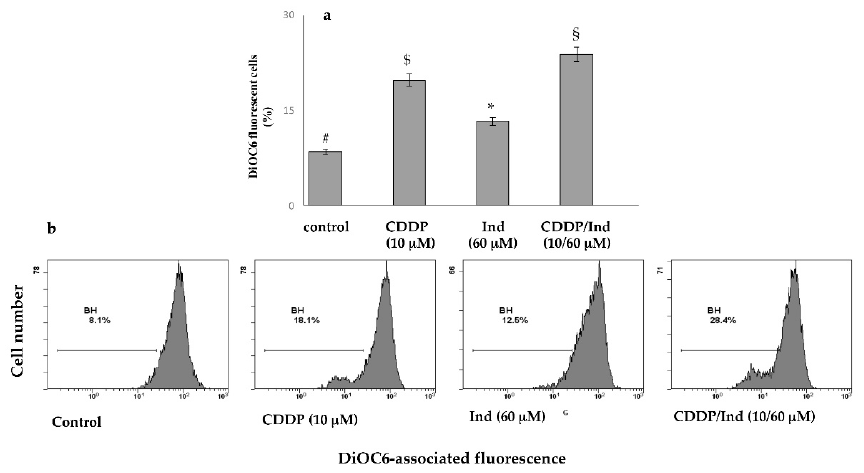
Figure 6. Depolarization of mitochondrial membrane potential induced by CDDP, Ind and CDDP/Ind combination on HeLa cells. Cells were treated for 24 h as described in Methods. Then percentage of DiOC6 stained-HeLa cells were determined by flow cytometer and compared to untreated cells (control). ( a ) Mean values ±SD of three separate experiments in triplicate. Bars without a common symbol are significantly different with p < 0.05 (one-way Anova associated with Tukey’s post hoc test); ( b ) Representative images.